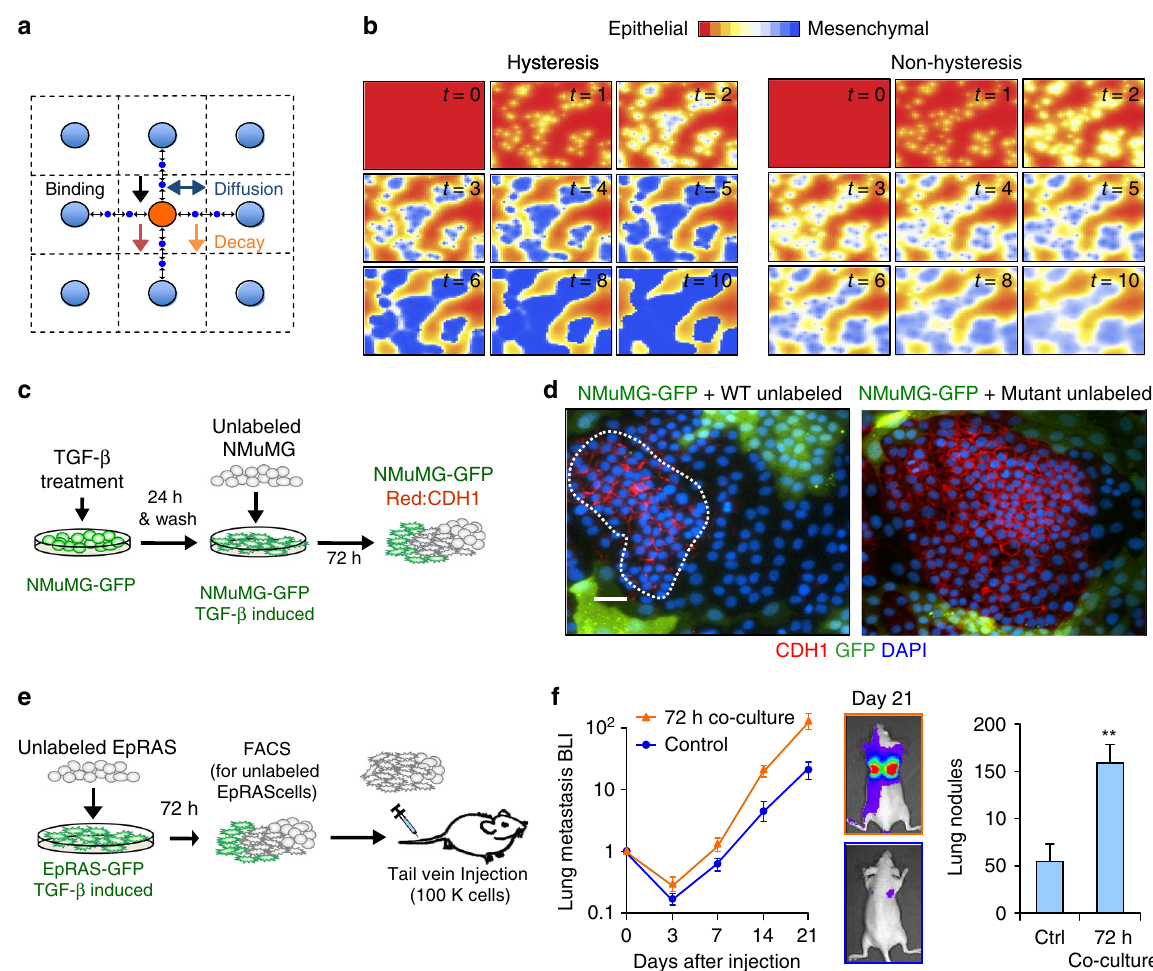
Fig. 4 Hysteresis fosters the EMT neighborhood spreading effect. a Euclidean stencil grid representing the parameters considered for the neighborhood effect computation. b Computational spatial simulation of the EMT spreading paracrine effect with and without hysteresis in a population of cells at different time points. c Schematic representation of the co-culture treatment process. NMuMG-GFP cells were induced with 100 pM TGF- β and for 24 h, after which unlabeled NMuMG cells were added into the culture. Immuno fl uorescence analysis was performed 72 h later. d Immuno fl uorescent images showing loss of CDH1 expression (red) in GFP-positive cells that were pre-treated with TGF- β to undergo EMT. Among GFP-negative wild type cells that rest (highlighted by dashed line) remained epithelial (left panel). Most of GFP-negative mutant were not able to undergo EMT through the neighborhood effect (right panel). Scale bar: 20 μ m. e Schematic representation of co-culture procedure of EpRAS cells (left). EpRAS-GFP cells were induced with 100 pM TGF- β and for 24 h, after which unlabeled EpRAS cells were added into the culture. After 72 h of co-culture, GFP-positive and -negative cells were separated by fl ow cytometry. 100,000 unlabeled EpRAS cells with or without the co-culture treatment were injected by tail vein injection into Ncr-nu/nu mice ( n = 6 mice). f Left: bioluminescence imaging (BLI) quanti fi cation and representative images of the metastatic growth of EpRAS cells. Right: quanti fi cation of lung metastasis nodules ( n = 6 mice). Data represent mean±SEM. ** P < 0.01 by two-tailed Student ’ s t